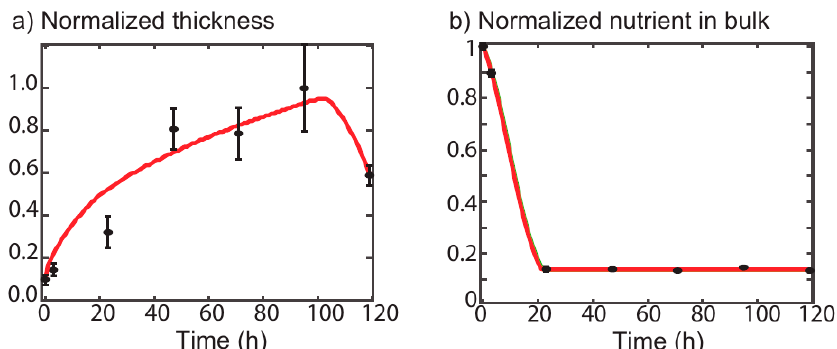
Figure 1. Best fit for the real data of the averaged nutrients and biofilm thickness dynamics predicted by the 1D model. Red line corresponds to the numerical results whereas the black points correspond to the experimental